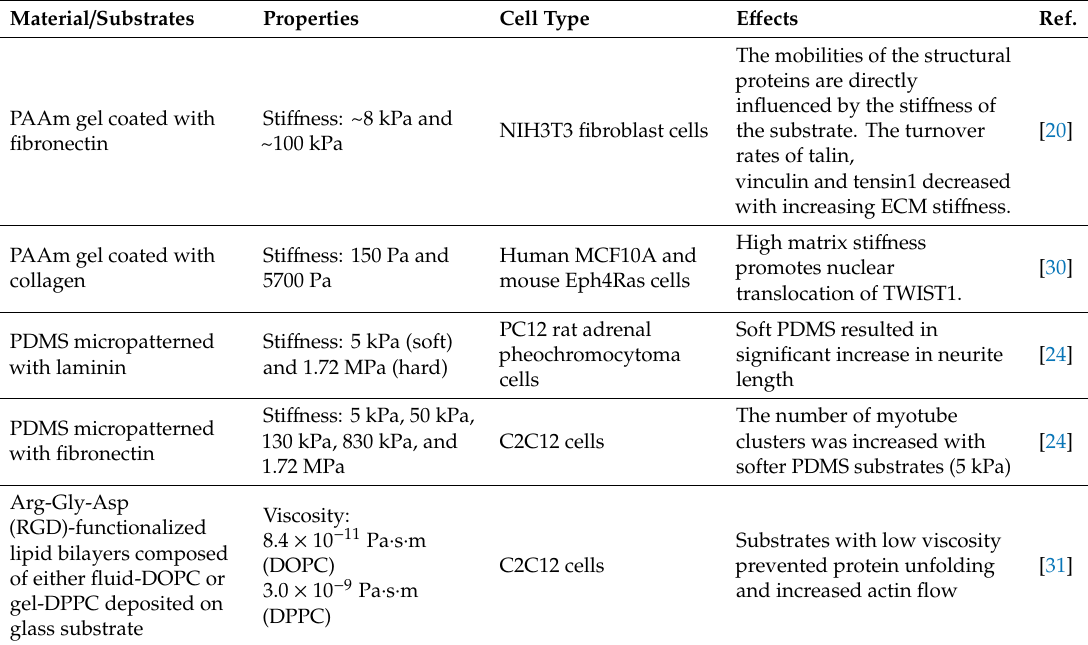
Table 1. Studies reporting the e ff ects of substrate sti ff ness and viscosity on